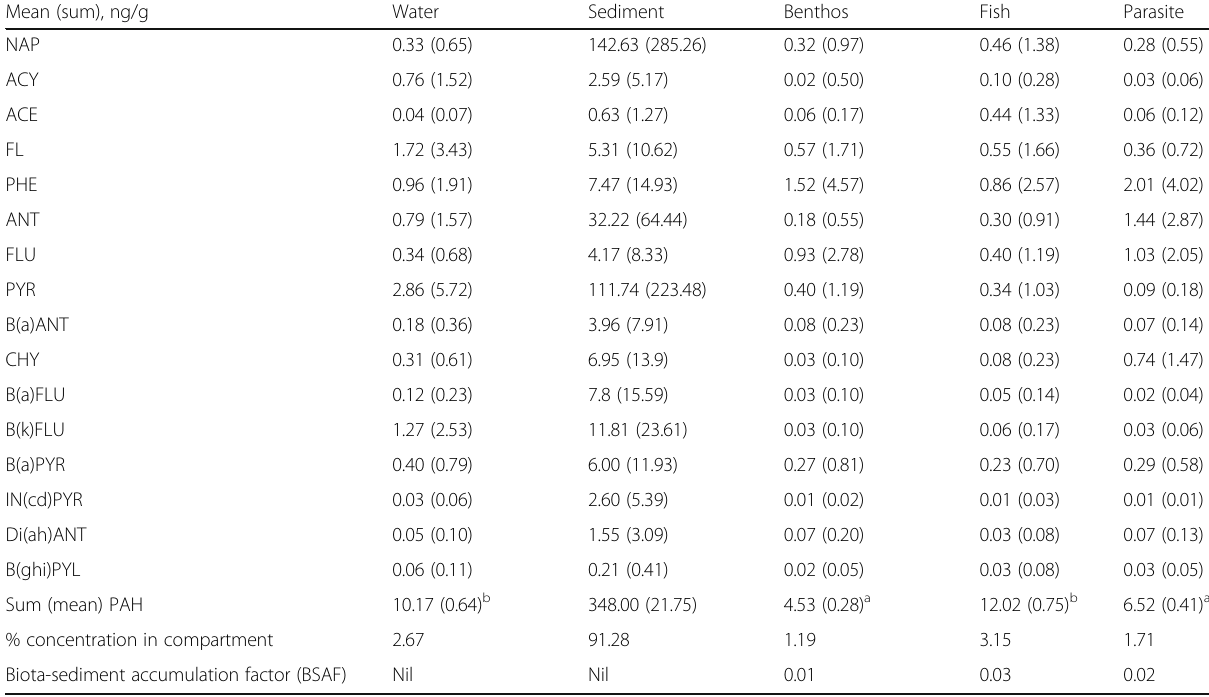
Table 4 Distribution in concentrations of PAH residues in compartments In Ilase water, Snake Island Mean (sum), ng/g